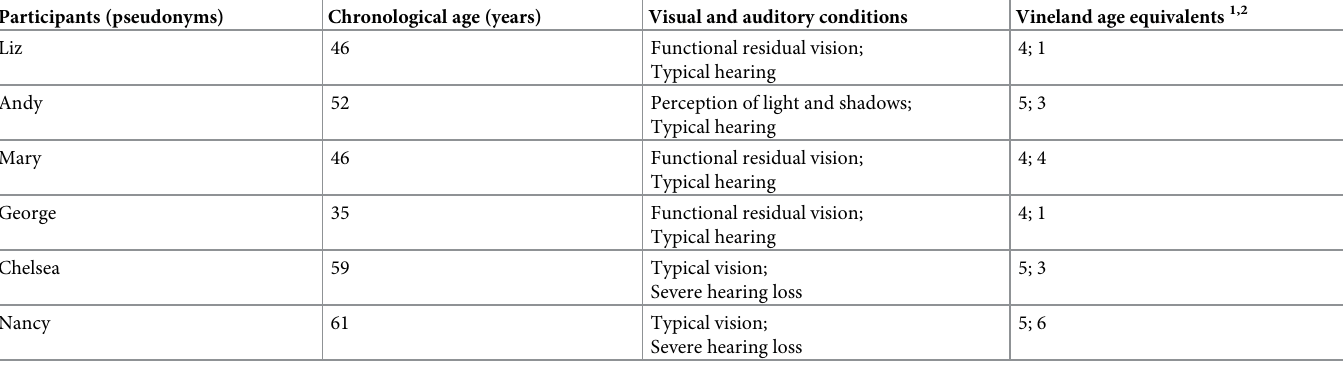
Table 1. Participants’ pseudonyms, chronological age, visual and auditory conditions, and Vineland age equivalents for daily living skills (personal sub-domain). Participants